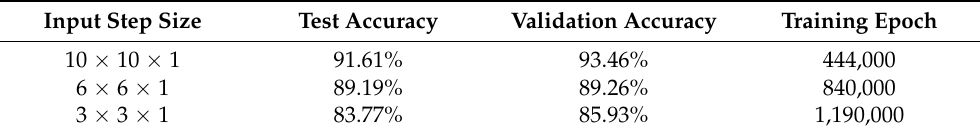
Table 3. Test accuracy results for TDK IMU accelerometer.